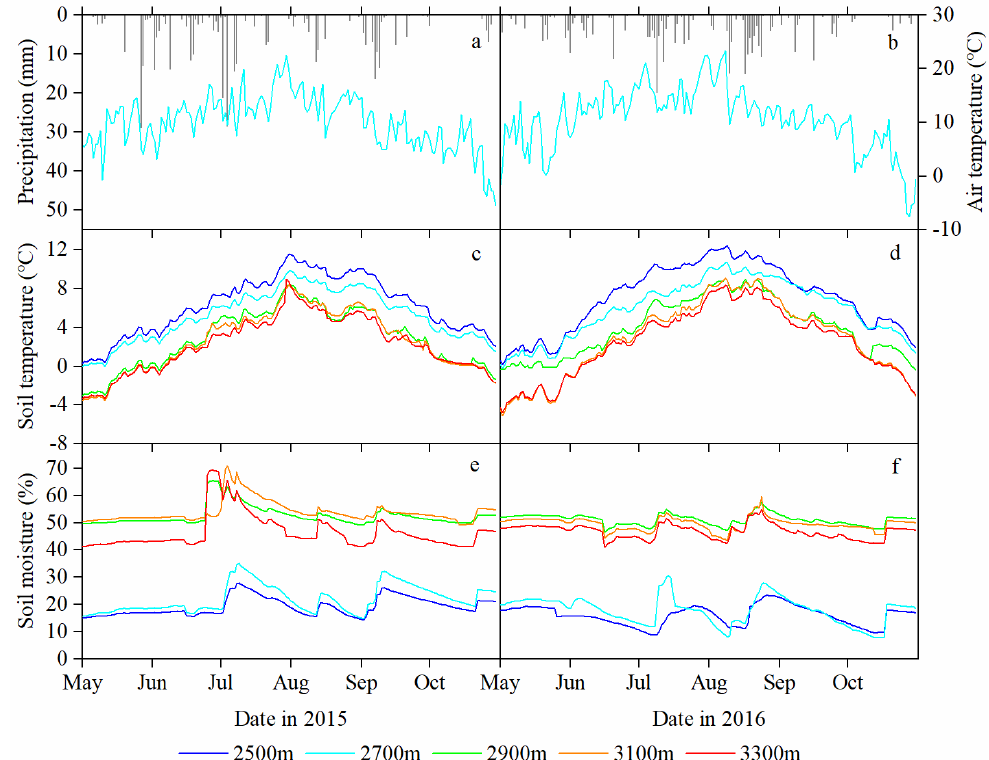
Figure 2. Daily variation of precipitation ( P ) and mean air temperature ( T a ) at 2700 m a.s.l., and edaphic factors (mean soil temperature ( T s ) and volumetric soil moisture content ( M s )) of the 0 to 60 cm soil layer at different elevations in the growing seasons of 2015 ( a , c , e ) and 2016 ( b , d , f ). However, the elevation change pattern of T s differed significantly from that of T a , and the pattern of M s was opposite that of T s . For the T s and M s , there is a critical line at the middle elevation (2900 m a.s.l.), i.e., there is markedly different change ratio both above and below this elevation. In 2015, the T s was approximately 6.0 ◦ C at low elevations (such as 6.28 ± 2.98 ◦ C and 5.23 ± 2.62 ◦ C at 2500 m and 2700 m a.s.l., respectively), whereas it was approximately 2.5 ◦ C at both middle and high elevations (2.86 ± 2.99 ◦ C, 2.59 ± 3.12 ◦ C and 2.27 ± 2.86 ◦ C at 2900 m, 3100 m and 3300 m a.s.l., respectively) (Figure 2c). The M s was approximately 20% at low elevations (such as 19.27 ± 3.37% and 22.12 ± 5.03% at 2500 m and 2700 m a.s.l.), respectively, whereas it was approximately 50% at middle and high elevations (52.58 ± 3.57%, 53.97 ± 3.98% and 46.62 ± 6.36% at 2900 m, 3100 m